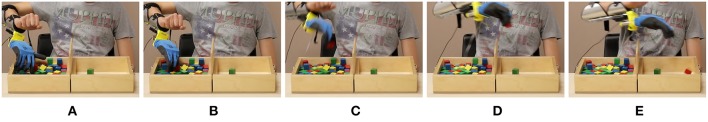
Photo-sequences of a single block transport in the Box and Blocks task. Map 3 (EMG-only) is used, and the device is in mode 2. In panels (A,B), the operator exploits both DoAs of the soft hand to pick the red block through a pinch grasp. In panels (C,D) the block is firmly maintained between thumb and index while being moved from let to right. In panel (E) the operator opens the hand, and releases the block into the empty box.